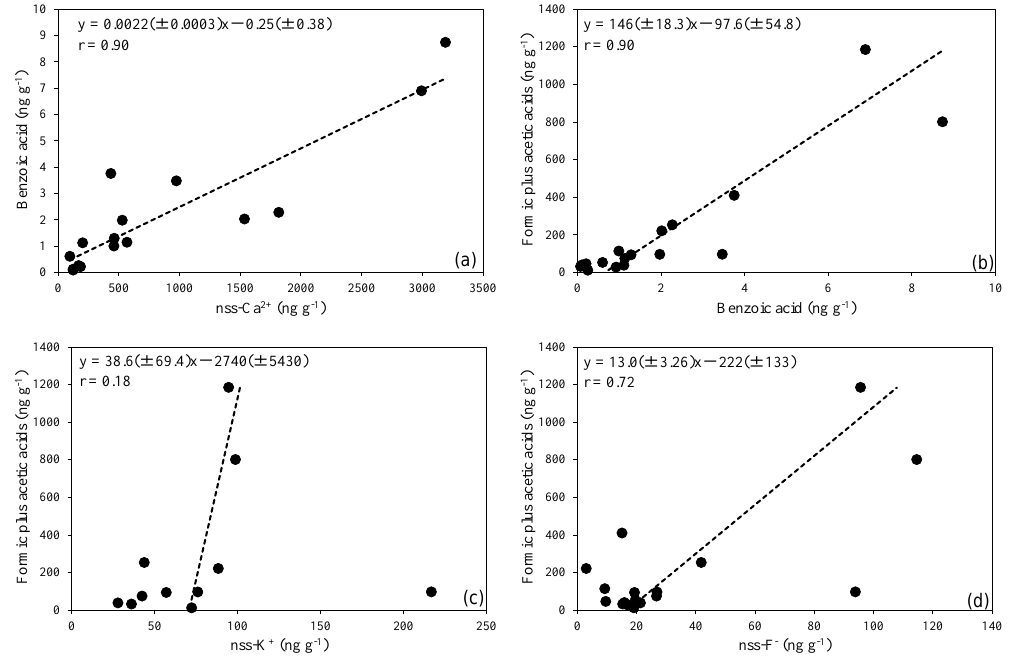
Figure 8. Scatter plots of (a) concentrations of benzoic acid vs. nss–Ca 2 + , (b) formic plus acetic acids vs. benzoic acid, (c) formic plus acetic acids vs. nss–K, and (d) formic plus acetic acids vs. nss–F − in Mt. Tateyama snow samples. The dotted line represents the Deming linear regression.